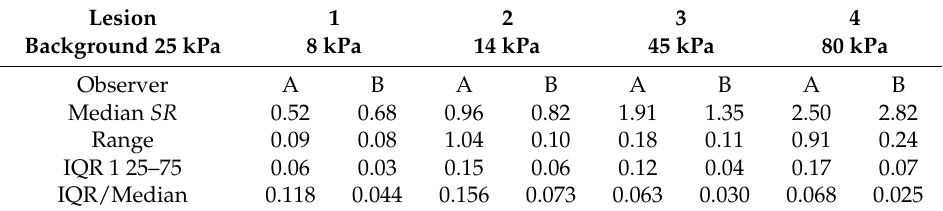
Table 1. Elastography strain ratio ( SR ) in four inclusions in a tissue-mimicking phantom.